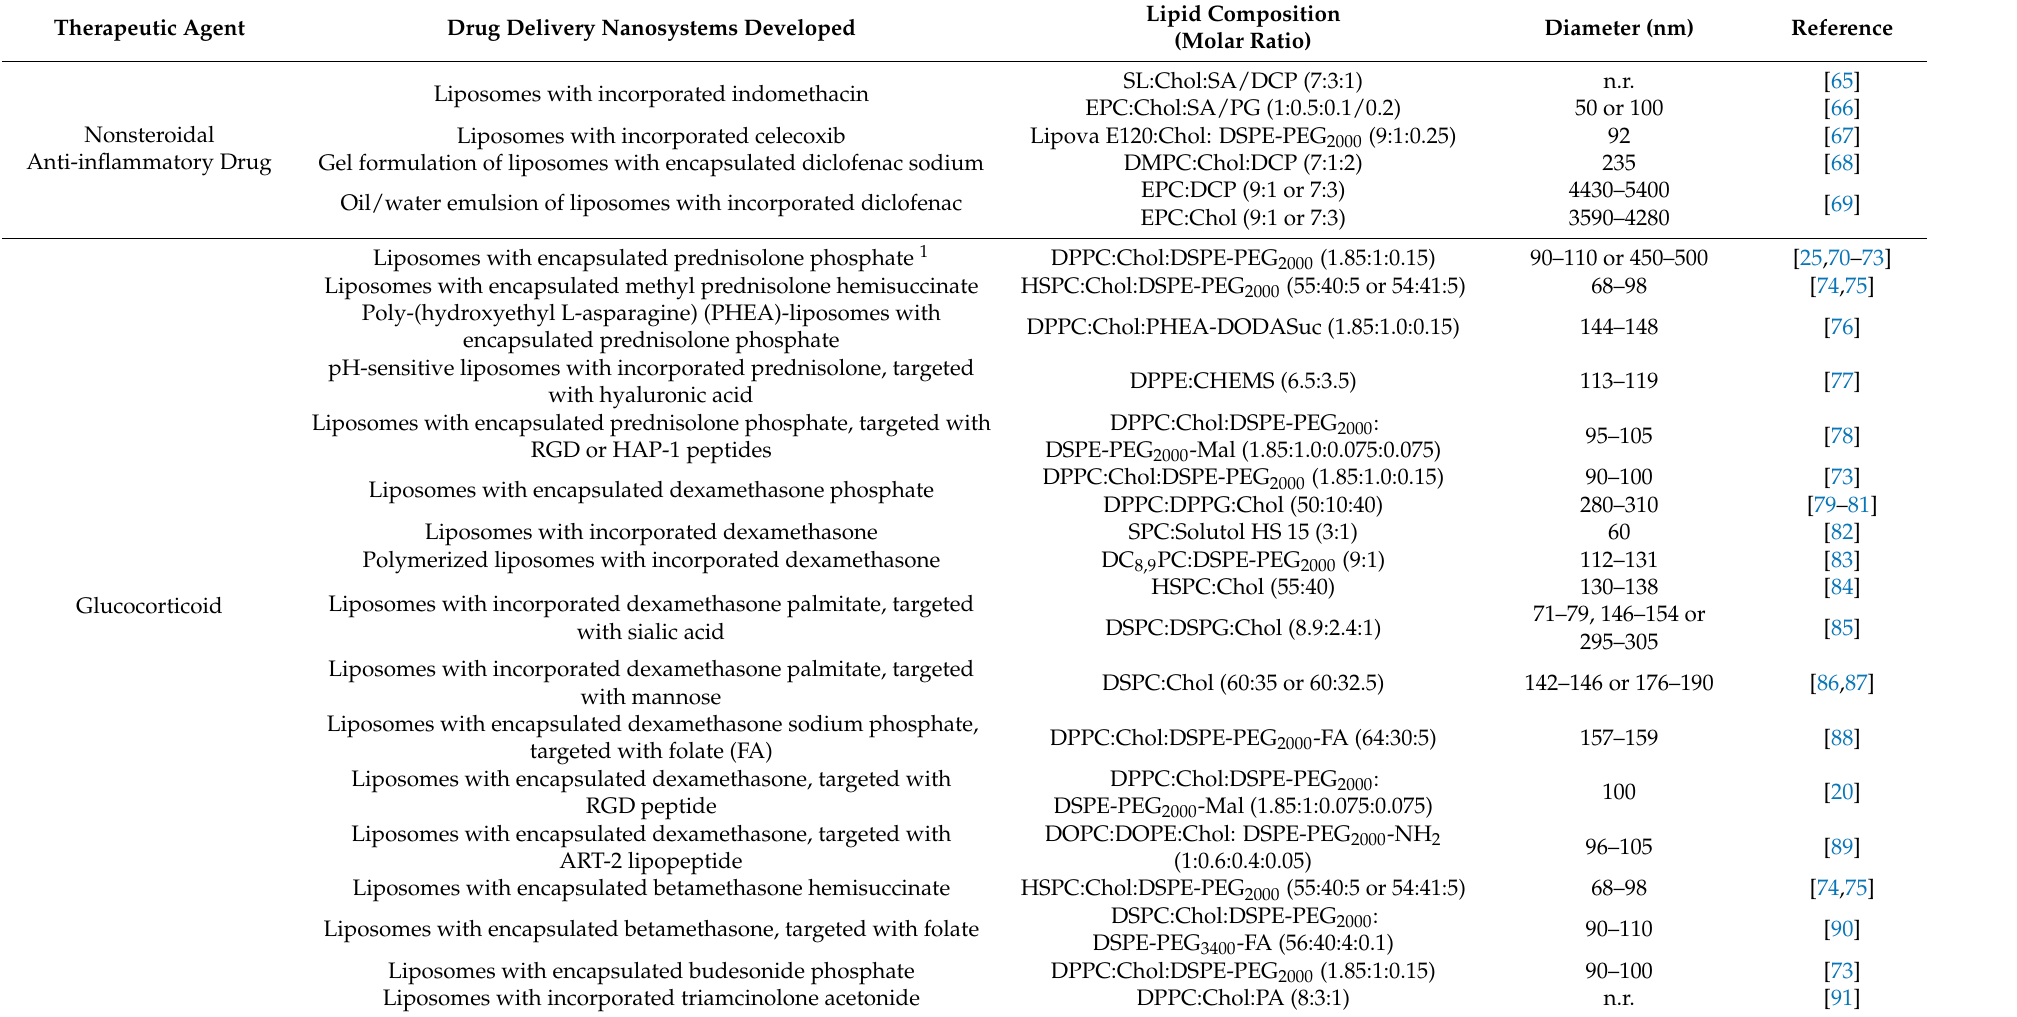
Table 1. Examples of liposomes developed for rheumatoid arthritis treatment divided according to the therapeutic agent used. The lipid composition, the corresponding molar ratio and the mean diameter were indicated for each liposomal